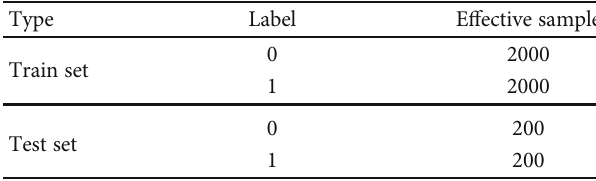
Table 2: Data set.